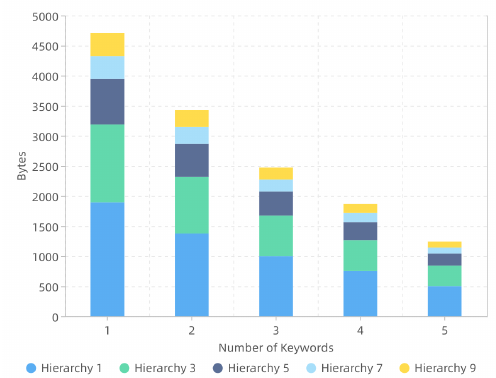
Figure 4. The Relationship of Communication Sizes and